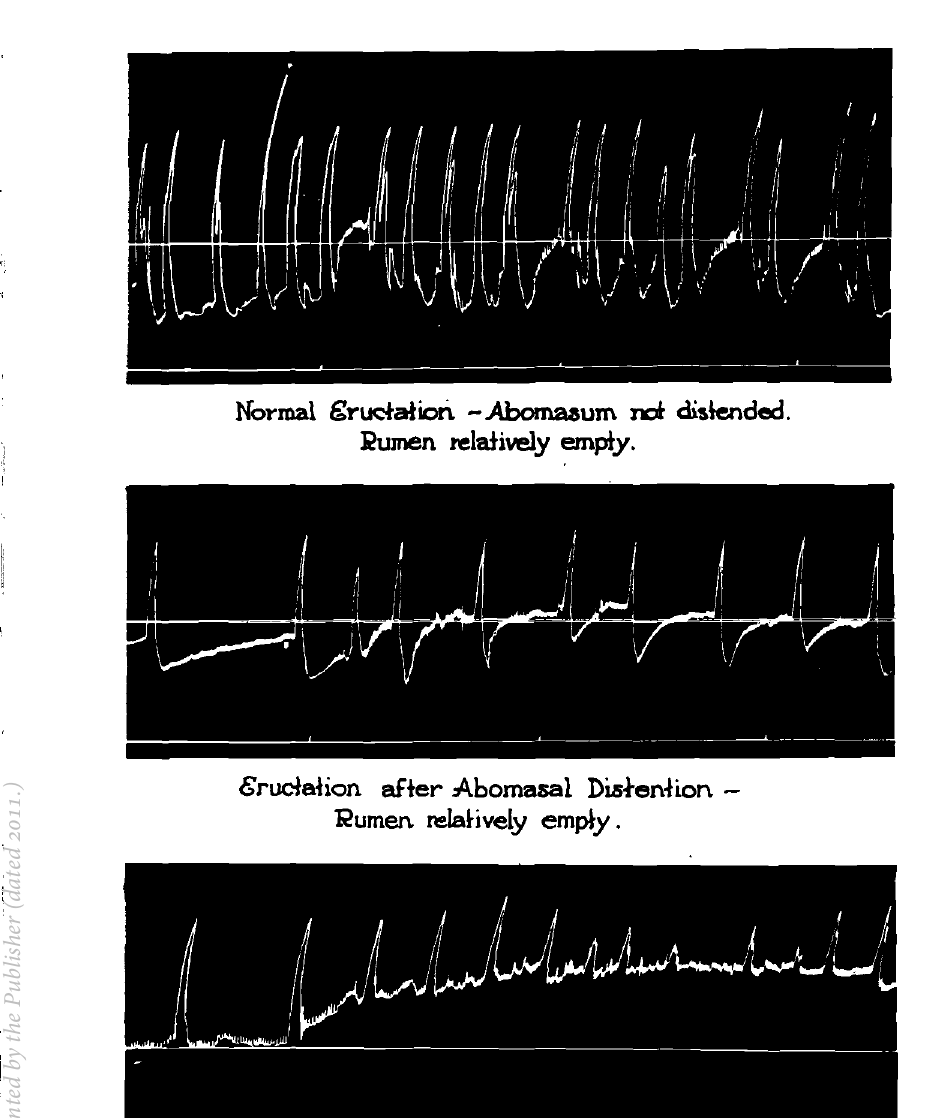
Fig. 9. THE EFFECT OF ABOMASAL DISTENTION ON